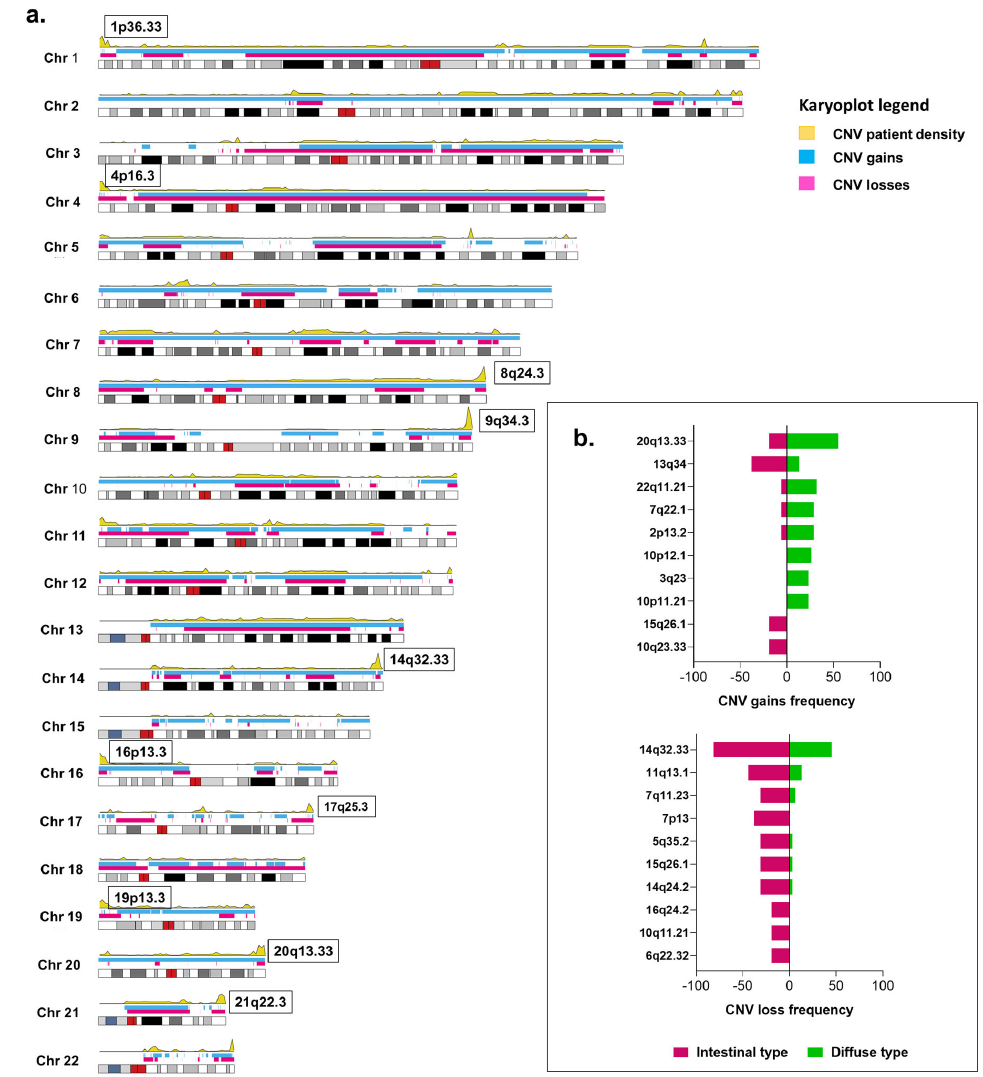
Figure 4. Copy number variations (CNVs) present in patients with gastric adenocarcinoma treated at The Instituto Nacional de Cancerología between January 2019 and January 2020 (n = 49). ( a ) Karyoplot depicting the genomic regions affected by CNVs in all the patients (n = 49). Blue represents the CNV gains, pink, the CNV losses. The yellow density plot represents the frequency of patients affected by CNVs across the genome. Top ‐ ten frequently affected cytobands across all samples are shown in a box in bold. ( b ) Divergent bar plot showing the comparison between the affected cytobands in patients with diffuse ‐ and intestinal ‐ type gastric cancer. When grouping the patients according to their tumor histology (Figure 4b), patients with diffuse ‐ type GA tended to have gains in 20q13.33 ( p ‐ value = 0.01, FDR = 1) and 22q11.21 ( p ‐ value = 0.04, FDR = 1), whereas patients with intestinal ‐ type GA presented a higher frequency of CNV losses in 7p12 ( p ‐ value < 0.01, FDR = 0.27), 14q24.2 ( p ‐ value = 0.01, FDR = 0.66), and 11q13.1 ( p ‐ value = 0.02, FDR = 0.66). Patients with intestinal ‐ type